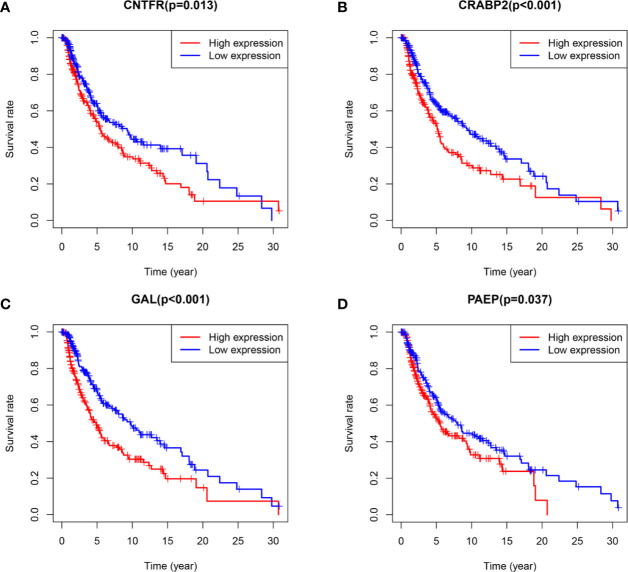
Survival analysis of four hub TMB-related signature with P value of log-rank test. (A–D) Higher expression levels of CNTFR, CRABP2, GAL, and PAEP correlated with poor survival outcomes, respectively. TMB, tumor mutation burden; CNTFR, ciliary neurotrophic factor receptor; CRABP2, cellular retinoic acid binding protein 2; GAL, galanin and GMAP prepropeptide; PAEP, progestogen-associated endometrial protein.